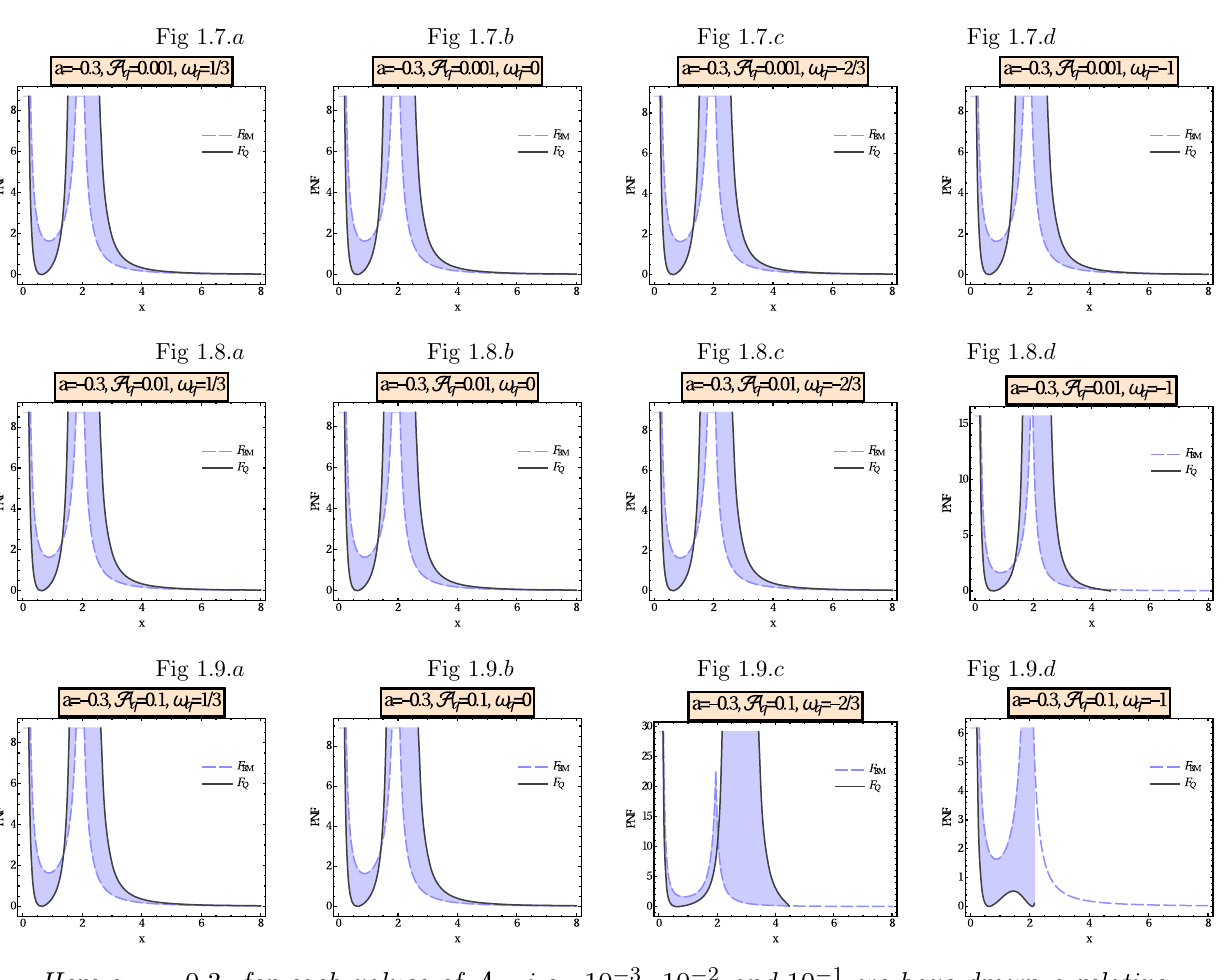
Fig 1 . 7 .a Fig 1 . 7 .b Fig 1 . 7 .c Fig 1 . 7 .d